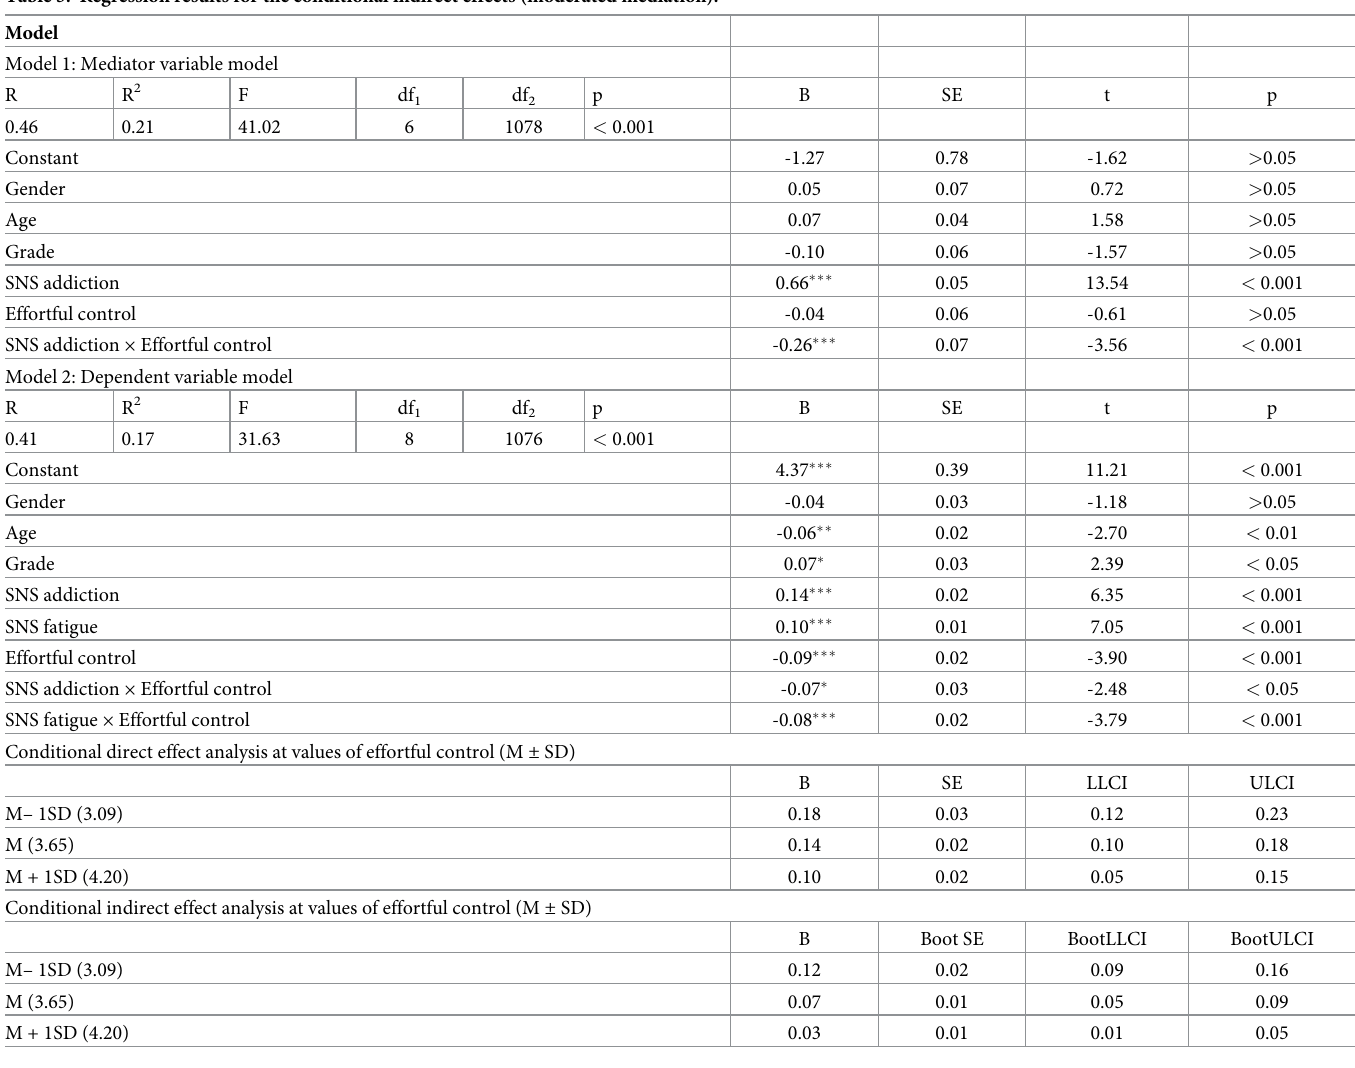
Table 3. Regression results for the conditional indirect effects (moderated